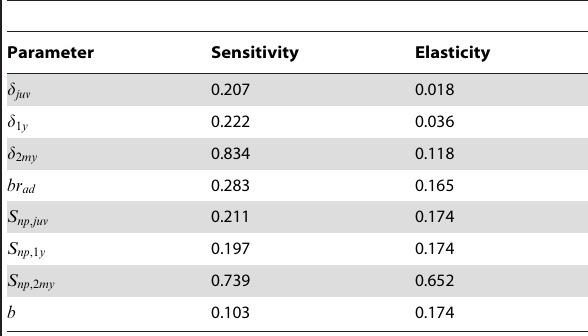
Table 2. Sensitivity and elasticity of population growth rate of the Red kite population of the island of Mallorca (Spain).